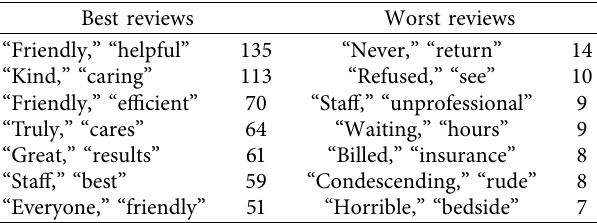
Table 9: Multivariate logistic regression of clinically relevant words ranked by likelihood of inclusion in positive reviews (odds ratio).